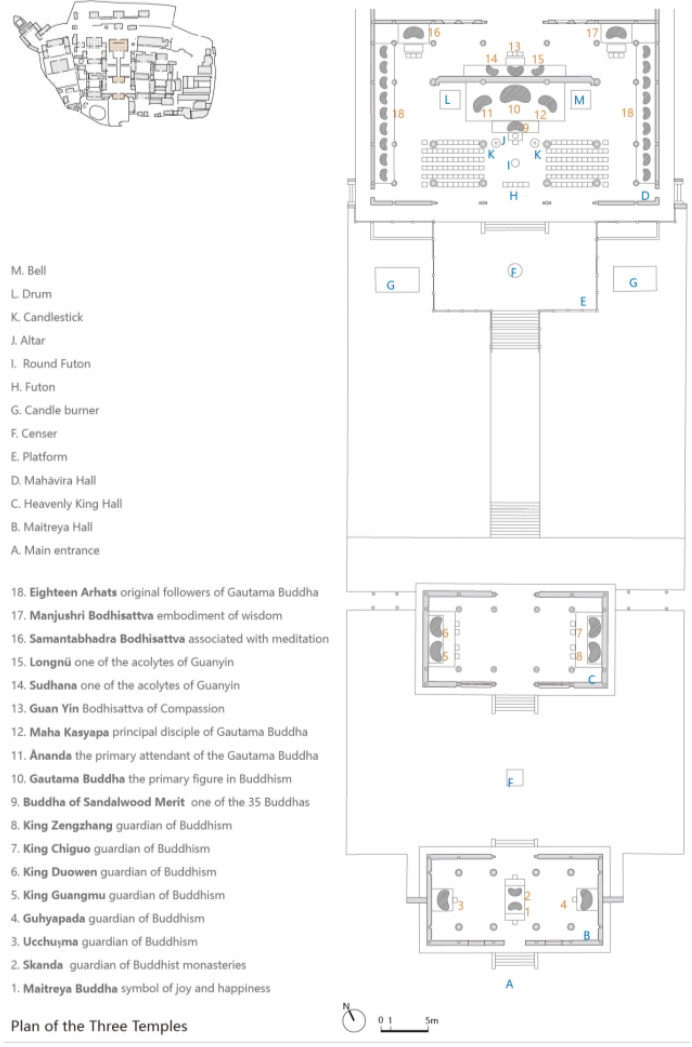
Figure 17. Plan of the Three Temples of Guoqing Si.